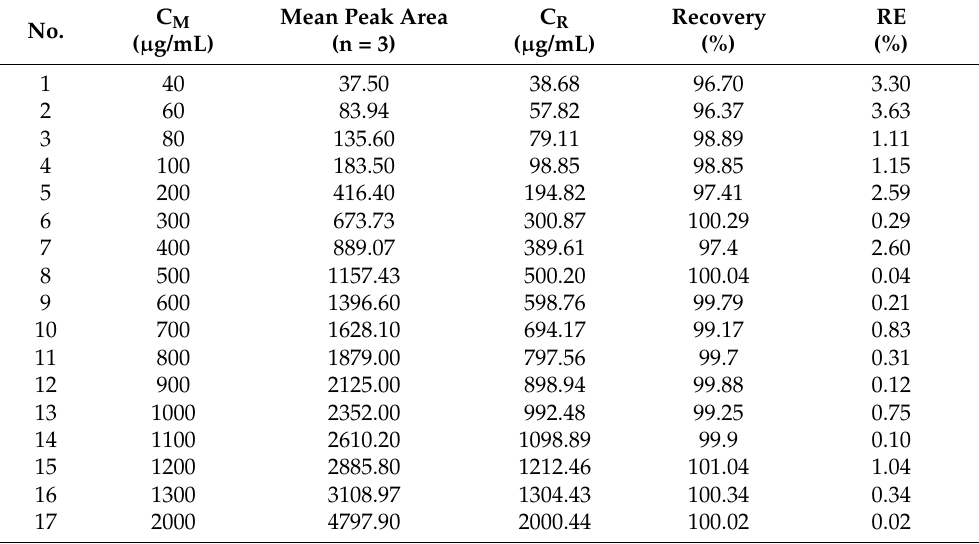
Table 8. Accuracy of the method in the range 40–2000 µ